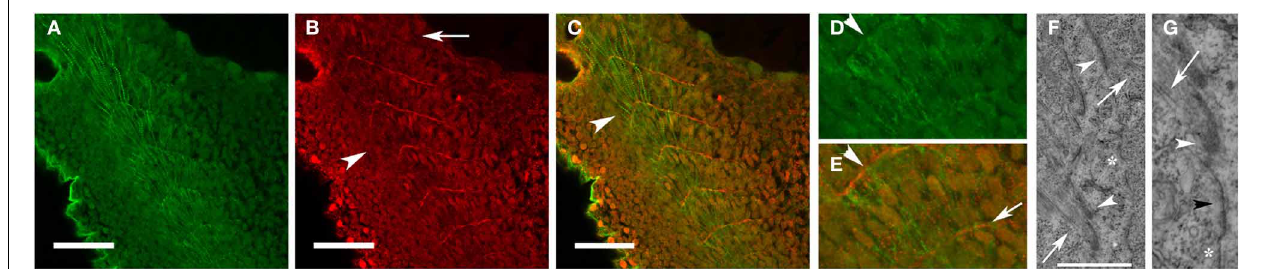
FIGURE 1 | Fibronectin organization at the somite boundary precedes the assembly and organization of new myofibrils. Zebrafish embryos at 24hpf were immunostained for fibronectin (red: B,C,E ) and α -actinin (green: A,C,D ). Fibronectin was organized at the somite boundary before the assembly of the first striated myofibrils ( B,C : arrowheads) and becomes less abundant in the more mature boundaries ( B : arrow). In the most recently formed somites, nascent myofibrils (D,E) , with a characteristic irregularly dotted pattern of α -actinin staining, extend between the recently formed fibronectin-containing nascentsomite/myotomeboundaries( E :arrow). (F) Insertionofactinfilaments (arrows) into membrane-based adhesion domains at the somite boundary is